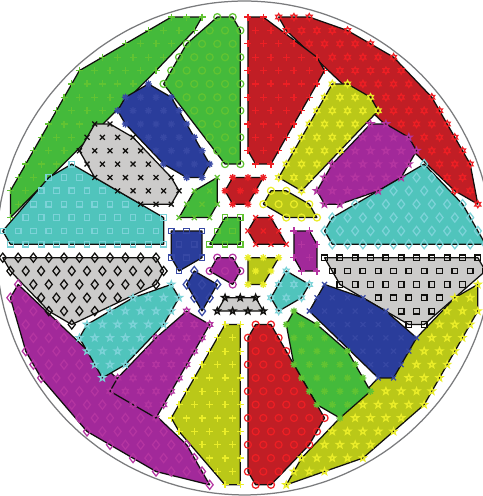
Figure 2: 2D generic array with 902 elements grouped into 32